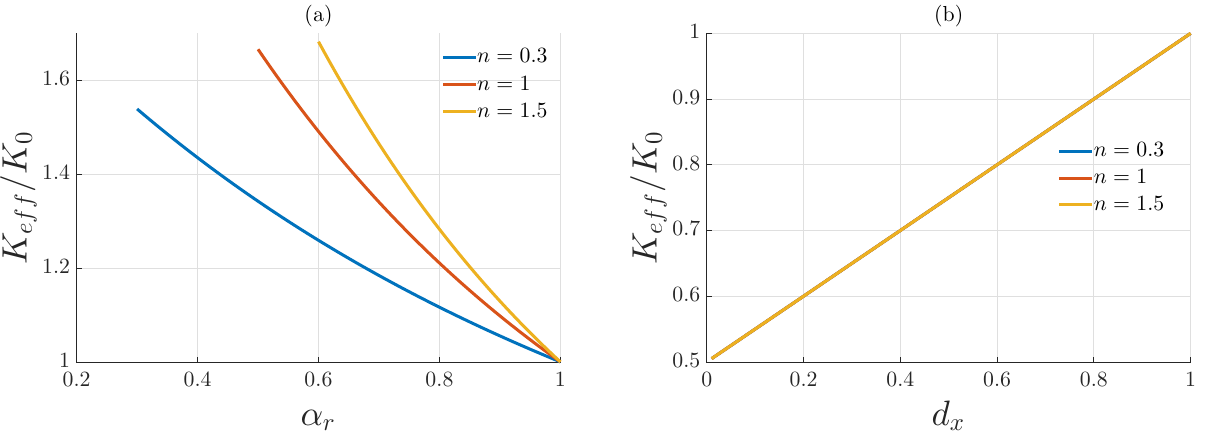
Figure 3. Plot of the effective consistency index of a fractal fluid defined by Equation (30) normalized by K 0 with respect to ( a ) α r and ( b ) d x , for different values of n